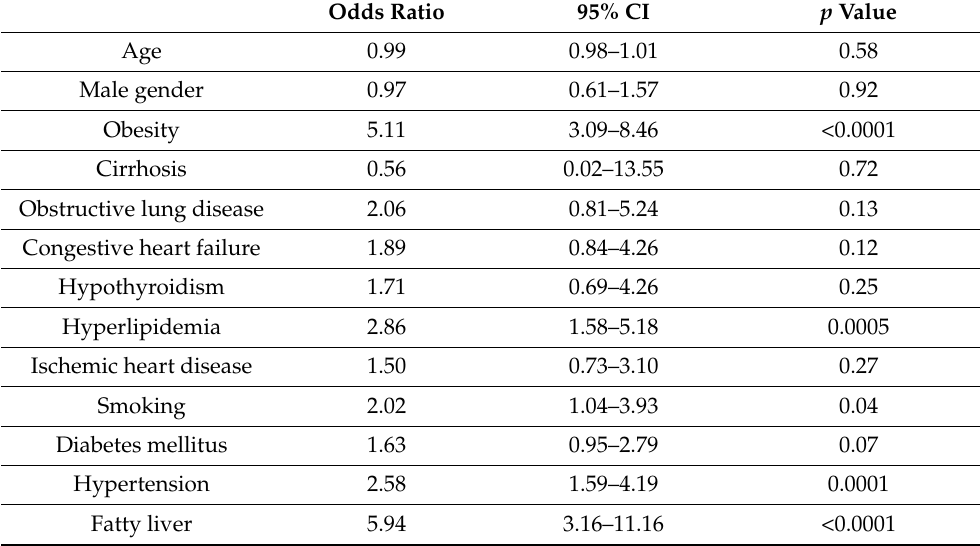
Table 2. Univariate analysis of parameters associated with fatty pancreas.